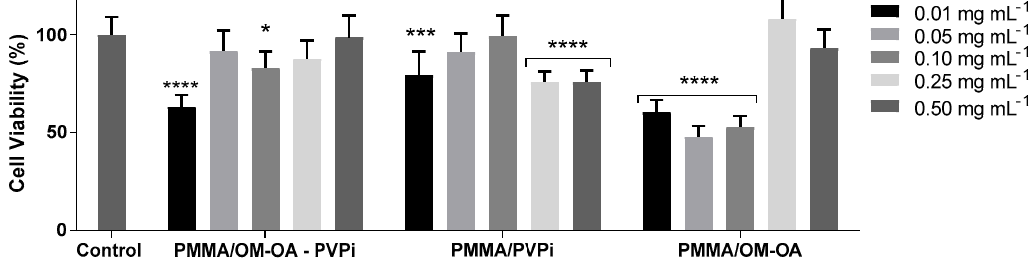
Figure 10. Evaluation of cytotoxic activity of poly(methyl methacrylate) / magnetic oxide coated with oleic acid / poly (vinyl pivalate)—(PMMA / OM-OA / PVPi), poly(methyl methacrylate) / poly (vinyl pivalate)—(PMMA / PVPi) and poly(methyl methacrylate) / magnetic oxide coated with oleic acid—(PMMA / OM-OA) in human keratinocyte cells, HaCaT, after 24 h in the concentrations of 0.01 mg · mL − 1 , 0.05 mg · mL − 1 , 0.10 mg · mL − 1 , 0.25 mg · mL − 1 , and 0.50 mg · mL − 1 . The asterisks are related to the statistical significance associated with di ff erent confidence levels: * for 95% with p ≤ 0.05, ** 99% with p ≤ 0.01, *** 99.9% with p ≤ 0.001 and **** 99.99% with p ≤ 0.0001.